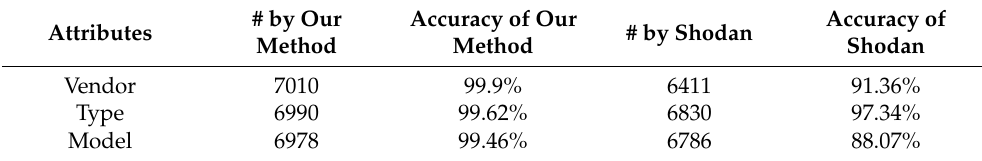
Table 5. Comparison of OCR-based method and Shodan.